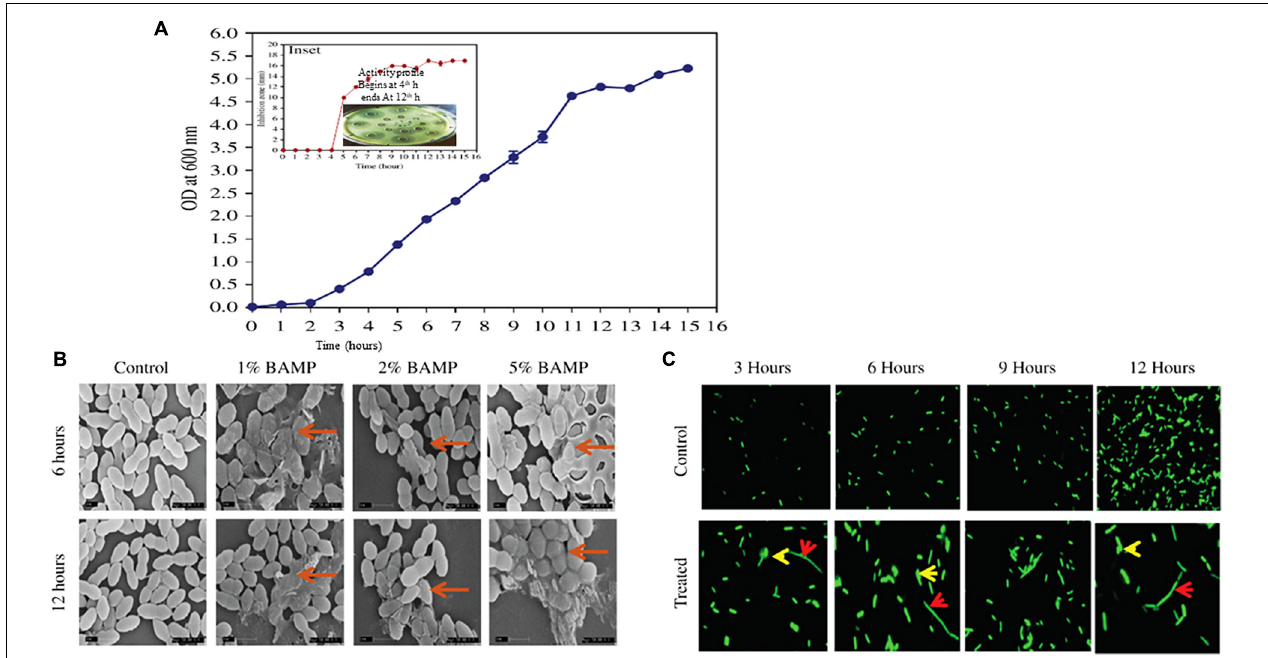
FIGURE 1 | (A) Growth curve of B. paralicheniformis . Inset shows antimicrobial protein production kinetics. The indicator strain used is V. harveyi . The inset shows diffusion assay of the zone formation which begins after 4 h of growth, and the peak ZOI continued to 12 h. (B) SEM images of the different percentages of BAMP-treated V. harveyi cells in its 6 and 12 h of growth. The arrows indicate the swollen and damaged cells. (C) Effect of BAMP on florescent-labeled S. typhi at regular intervals of growth is shown in comparison with the control. The elongated bacteria are shown with a red arrow; bulged cells are indicated with a yellow arrow.